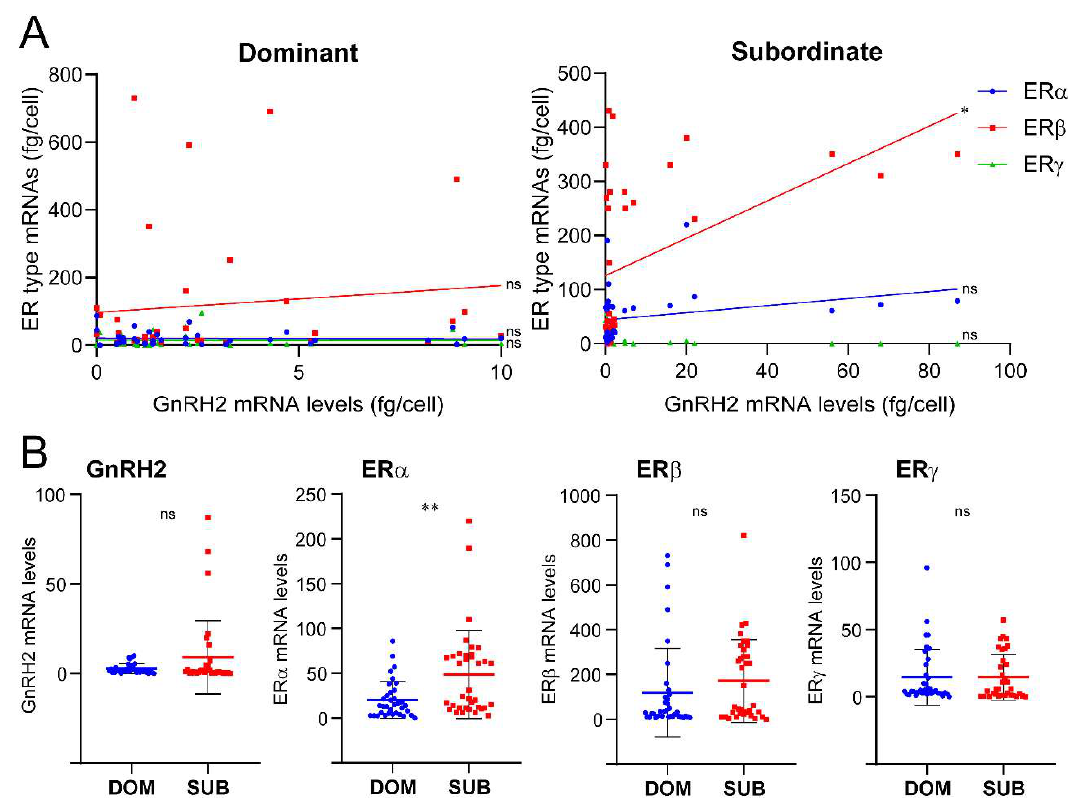
Figure 5. Expression of ER genes in GnRH2 neurons in dominant and subordinate male tilapia. ( A ) Graphs showing the expression of ERα (blue dots), ERβ (red dots) and ERγ (green dots) mRNA levels in individual cells in dominant and subordinate males. The X- and Y-axes represent the absolute mRNA levels (fg/cell) of GnRH2 and ER types in individual GnRH2 cells, respectively. ( B ) Scatter blot graphs showing mRNA levels of GnRH2 and ERα-γ in single GnRH2 cells in dominant (DOM, blue dots) and subordinate (SUB, red dost) males. Correlation of GnRH2 and ER types mRNA levels were examined by Pearson’s r, while the mean difference of GnRH2 and ER types mRNA levels between DOM and SUB were analyzed by an unpaired t test. p value: ** p < 0.01; ns, nonsignificant.